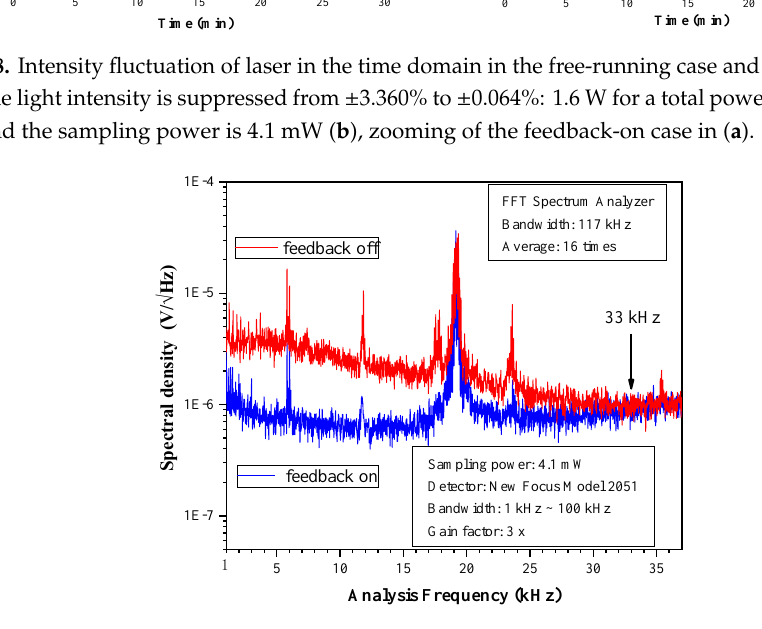
Figure 9. Comparison of the intensity fluctuation of laser in the frequency domain when feedback loop is on and off. The feedback bandwidth in the frequency domain is 33 kHz. Several noise peaks are occurring from the external environment or the YDFA’s cooling system.